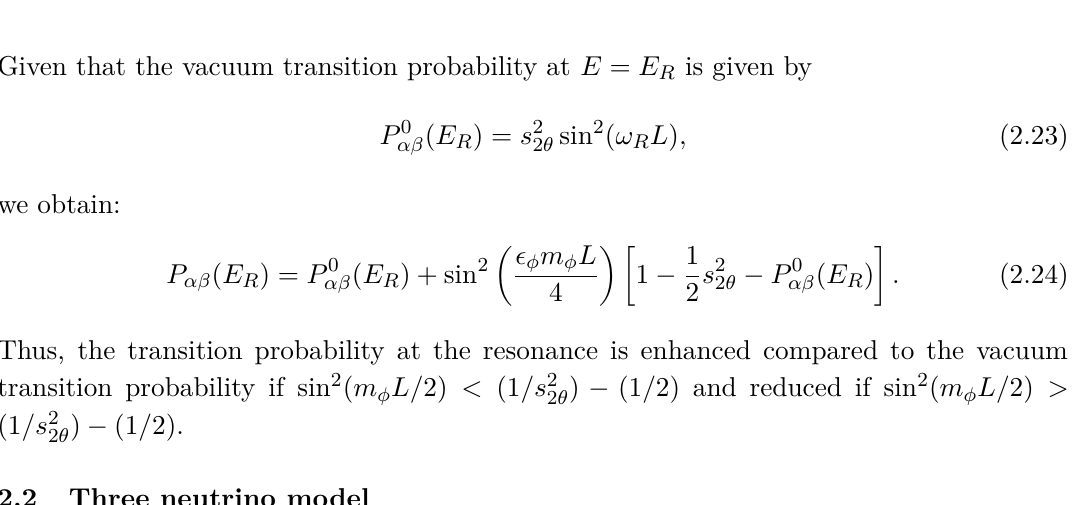
Figure 1 . P αβ ( δ E ) : (Left) (cid:15) φ m φ L (cid:29) 1 : the height of the resonance is O (1) , and the width is (cid:15) φ . (Right) (cid:15) φ m φ L (cid:28) 1 : the height of the resonance is ( (cid:15) φ m φ L ) 2 / 16 , and the width is 1 / ( m φ L )